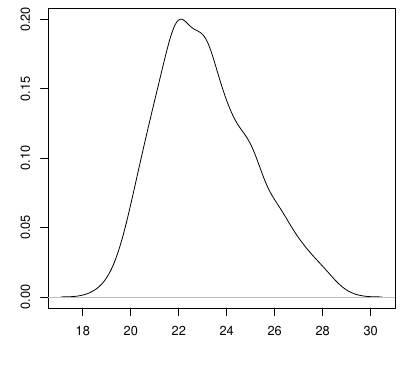
Figure 2 – A platykurtic distribution with kurtosis